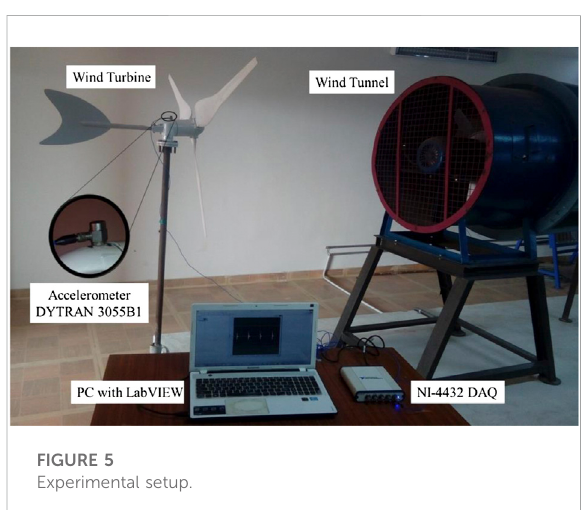
FIGURE 5 Experimental